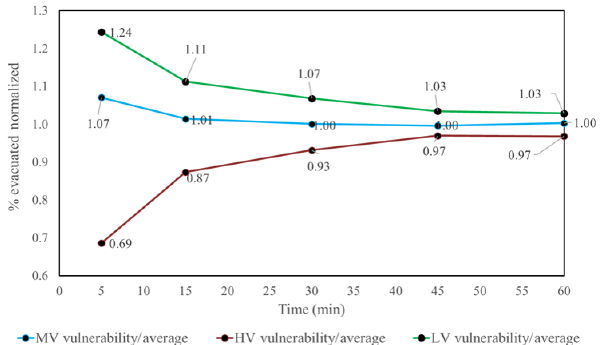
Figure 9. People evacuated per social vulnerability level normal- ized by the average number of people